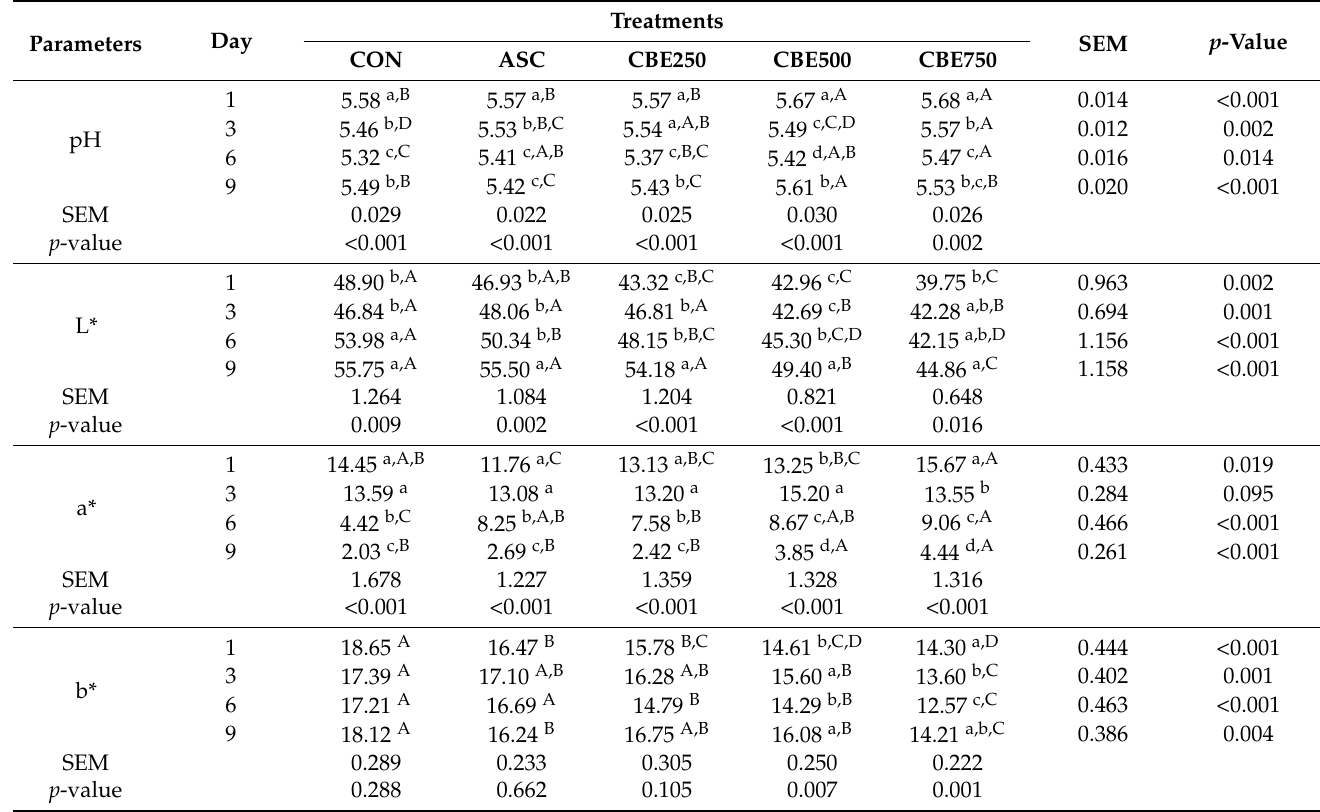
Table 3. Effect of the treatments in the pH and colour parameters (L*, a*, b*, C*, h*, and ∆ E s ) of the pork patties during